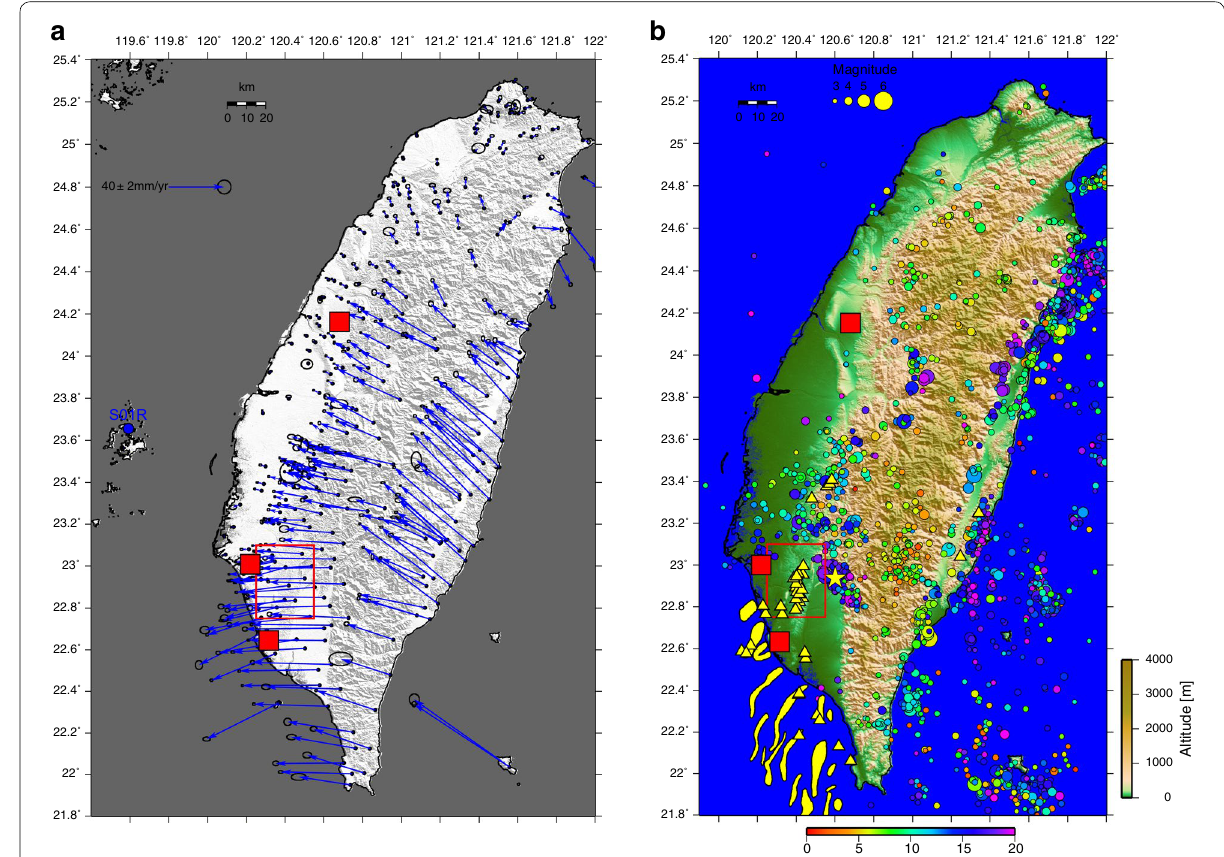
Fig. 1 Crustal deformation and seismicity in Taiwan. Red rectangle denotes the study area. Red squares stand for, from north to south, Taichung, Tainan, and Kaohsiung, respectively. a Horizontal velocity field with respect to S01R (Paisha, Penghu) obtained by GNSS measurements (Tsai et al. 2015). Ellipsoid indicates 95% confidence interval. b Hypocentral distribution of shallow earthquakes provided by Central Weather Bureau. Radius and color of circles indicate magnitude and depth of earthquakes, respectively. Yellow areas indicate mud diapirs (Lin et al. 2009). Yellow triangles indicate mud volcanoes (Sun et al. 2010). Yellow star indicates epicenter of the Meinong